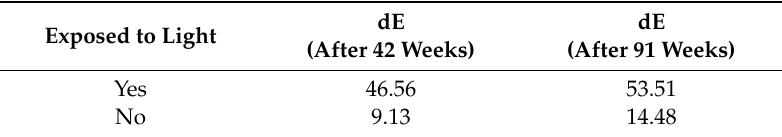
Table 3. Mean color di ff erence (dE) of specimens of sample set 2 ( n = 3) treated with iron (II) sulfate before and after 42 and 91 weeks. Three of the specimens were exposed to sunlight, 3 of them were kept in darkness (Figure